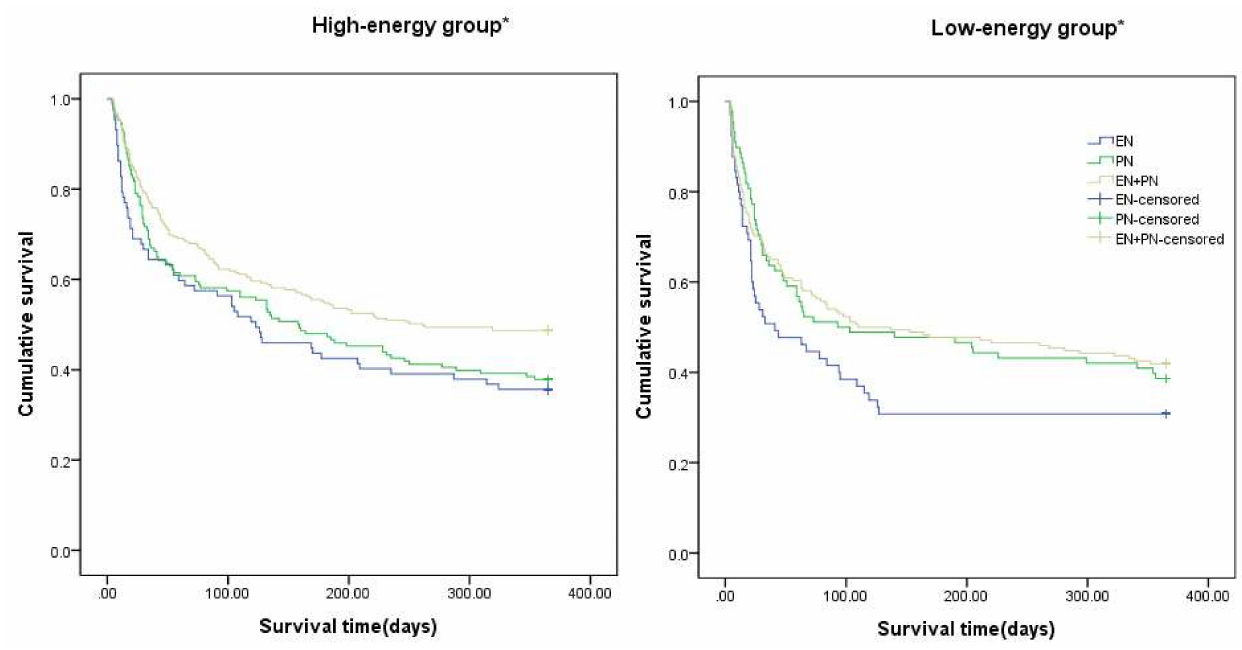
Figure 3. Kaplan–Meier curves for 1-year mortality according to the route of nutrition delivery in critically ill patients with sepsis in the low- and high-energy intake groups. * High-energy group, EN with supplemental PN was superior to only EN ( p = 0.016) or PN ( p = 0.042) in patients who met >70% of their nutrition requirement; low-energy group, route of nutrition supply was not associated with 1-year mortality in the group who met < 70% of their nutrition requirement. EN is the blue line, PN is the green line, and EN with supplemental PN is the purple line. EN, enteral nutrition; PN, parenteral